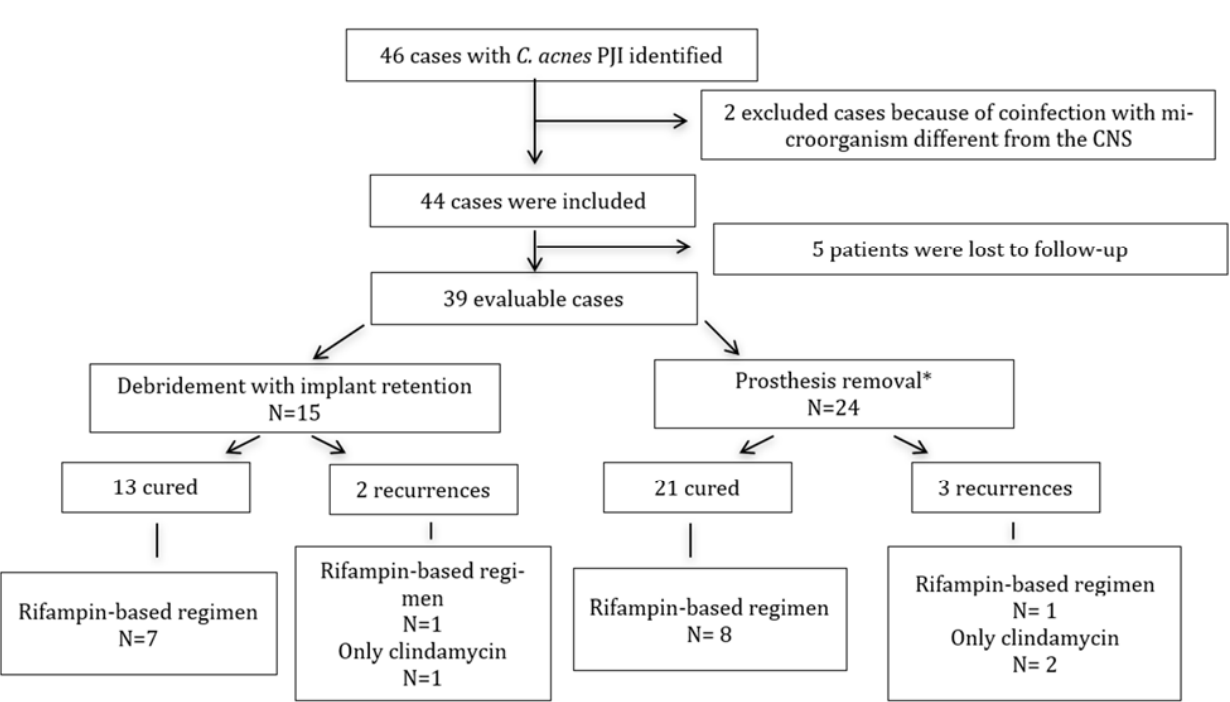
Figure 2. Flowchart of failure rates according to the medical and surgical approaches used. * Fifteen patients were treated with a two-stage procedure, six were treated with a one-stage procedure, one was treated with arthrodesis, and two were treated with resection arthroplasty.